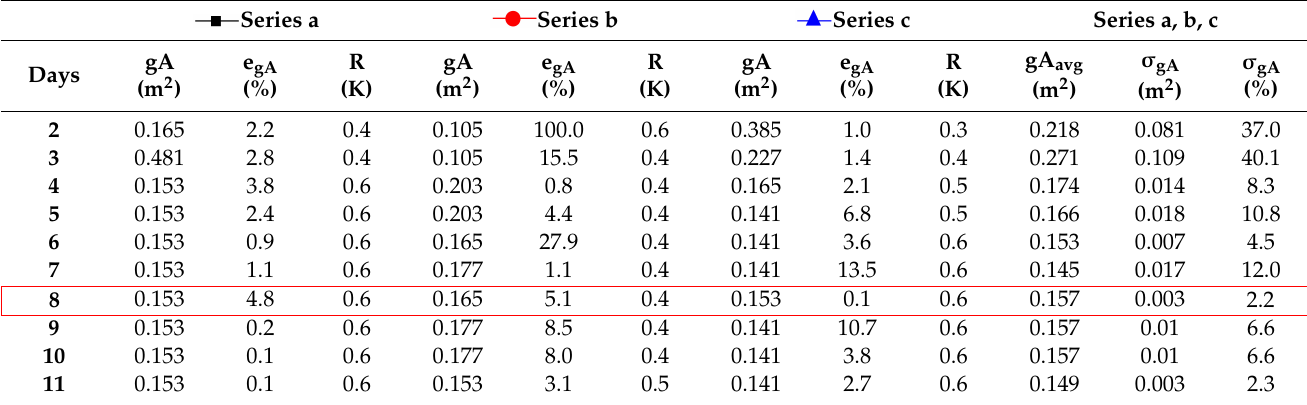
Table 13. Whole building. Comparison of the results for di ff erent test lengths. gA using the 3 nodes model with solar radiation and T i as